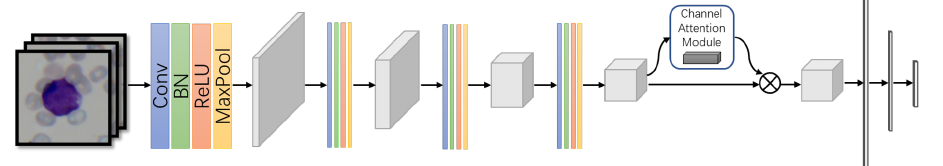
Figure 2. The architecture of the proposed compact model, containing four convolution blocks, one channel attention module and two fully-connected